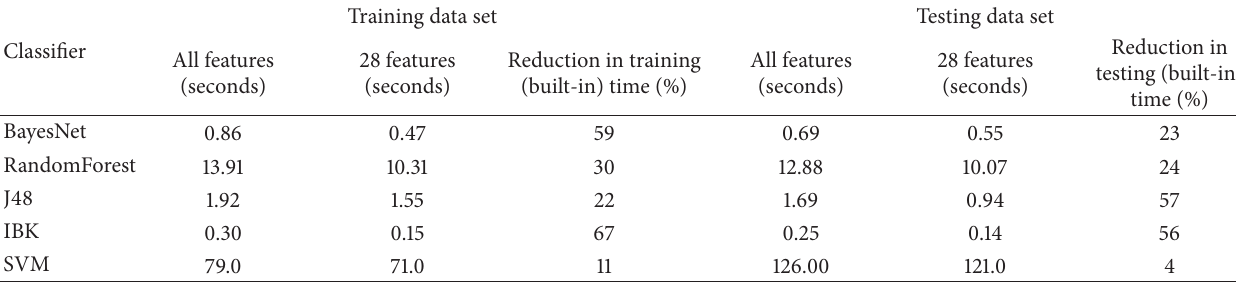
Table 5: Comparison of training and testing (built-in) time for different classifier using all and selected features.